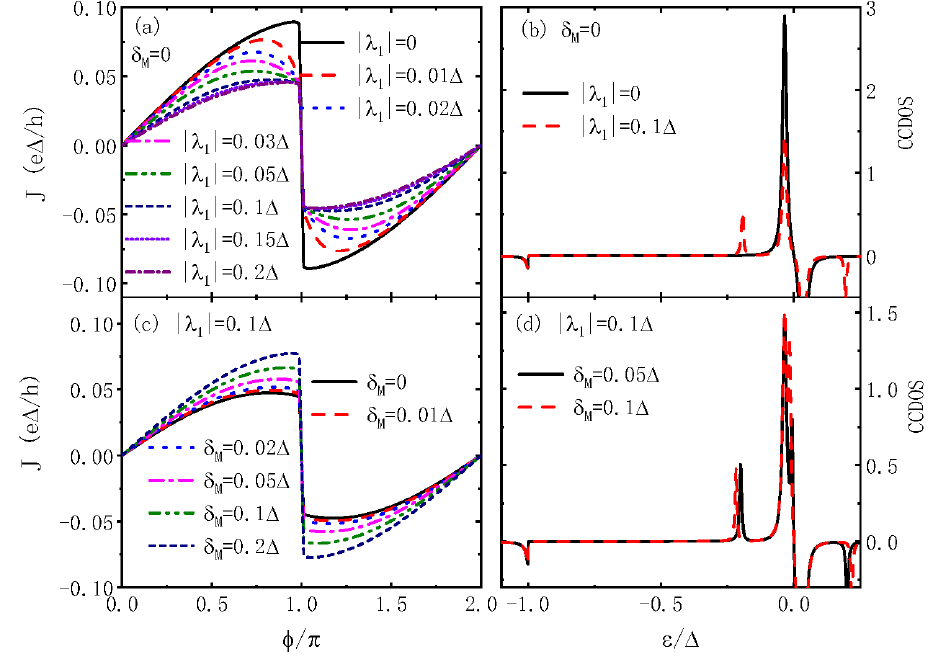
Figure 2. (color online) Josephson current in ( a , c ) as a function of φ and the current-carrying density of states (CCDOS) in ( b , d ) versus the electron energy for φ = 3 π /4 and different values of | λ 1 | , δ M . Other parameters are | λ 2 | = 0, φ M = 0 and ε d =